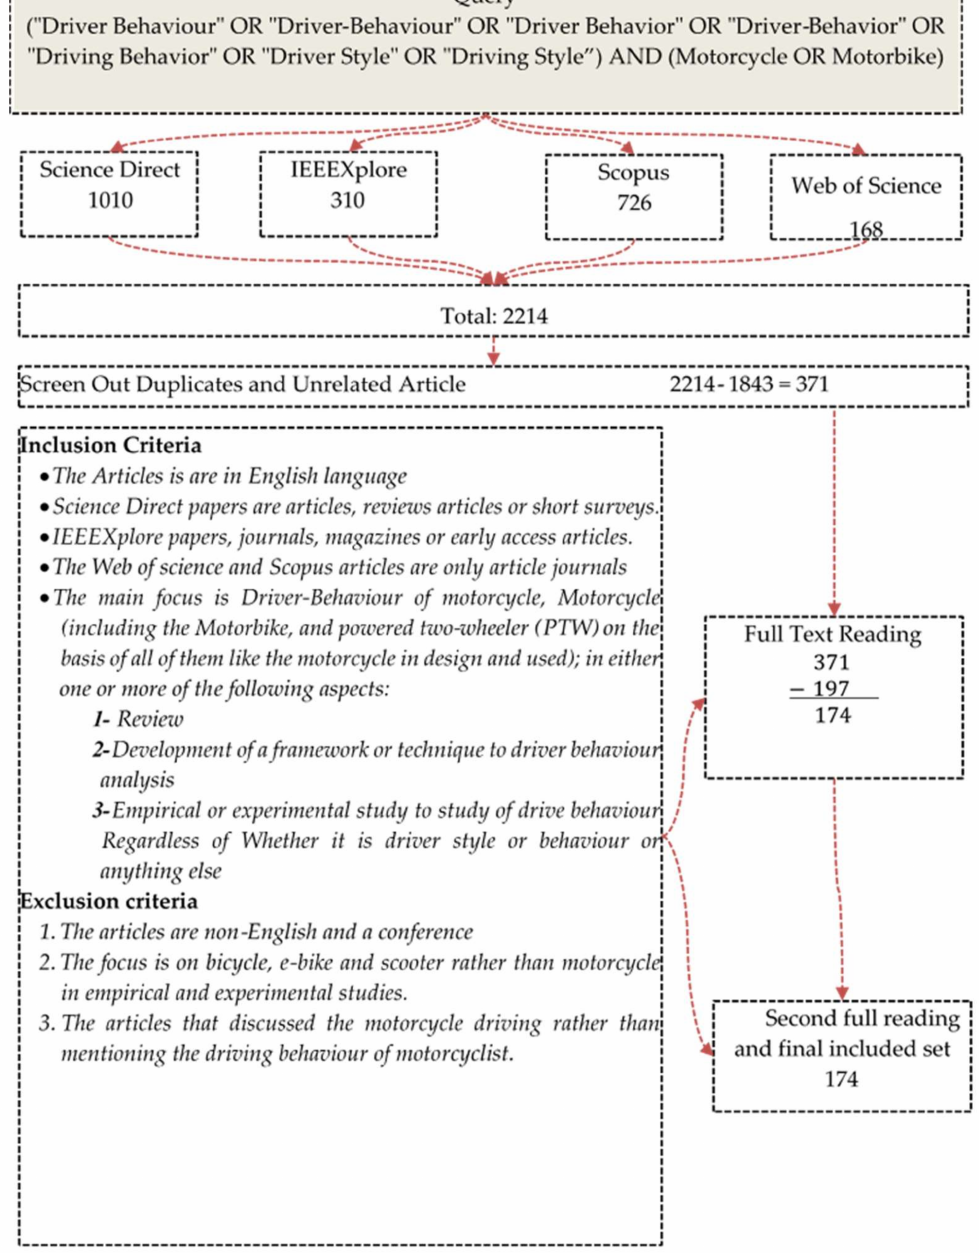
Figure 1. Selection of studies, search queries, inclusion and exclusion